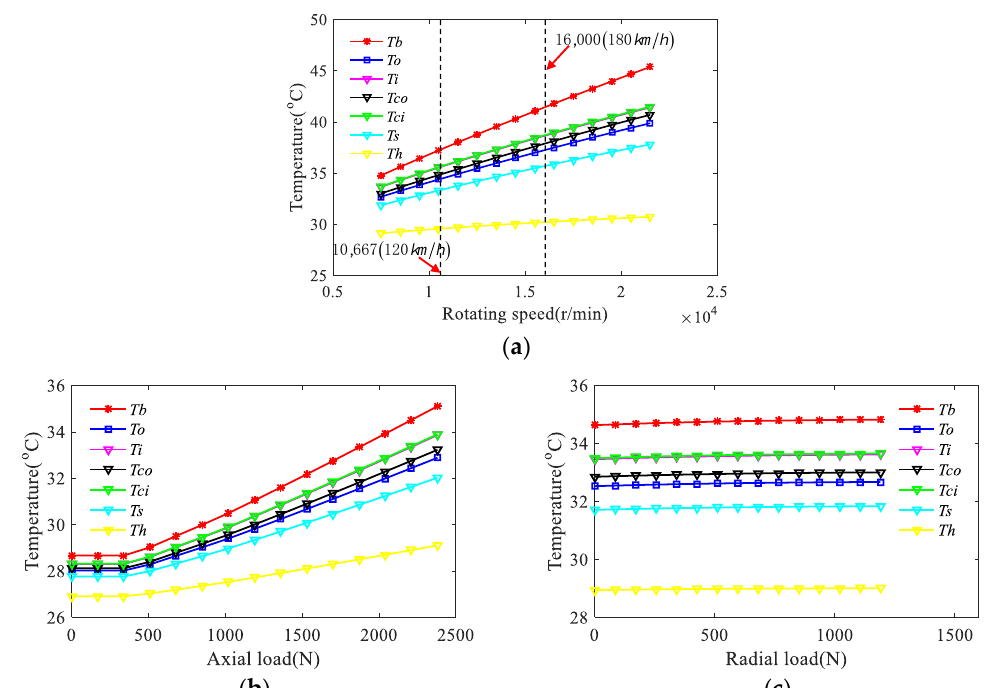
Figure 8. Temperature curve diagram of each node of the thermal network changing with the rotating speed and load: ( a ) node temperature variation diagram with the rotating speed under no-load, ( b ) node temperature variation diagram with axial load, and ( c ) node temperature variation diagram with radial load.